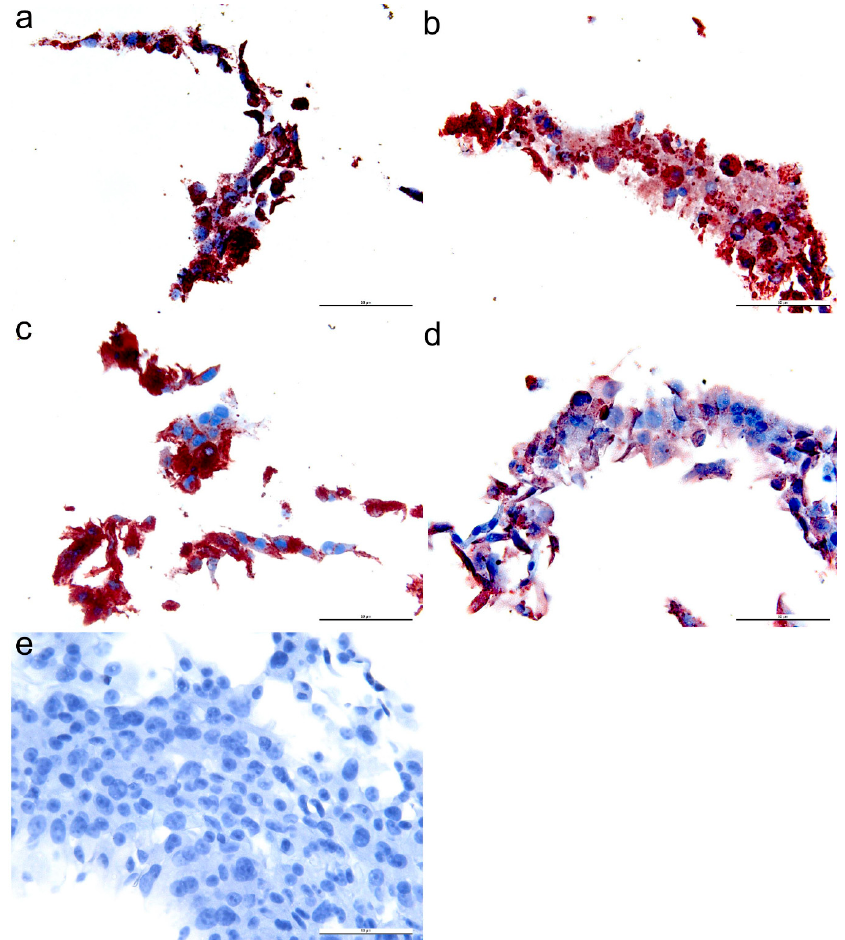
Figure 1. Immunohistochemical labelling of bluetongue virus (BTV)-1-infected baby hamster kidney cells (BHK-BSR) using BTV-specific antibodies. Non-structural (NS) 1 monoclonal antibody (mAb) 31D11 ( a ), NS2 mAb 30G4 ( b ), NS3 / 3a mAb 441 ( c ), and VP7 polyclonal antibody 20-3 ( d ). A representative image of immunolabelling of uninfected BHK-BSR cells with antibody NS2 mAb 30G4 ( e ). Bar = 50 μ m.